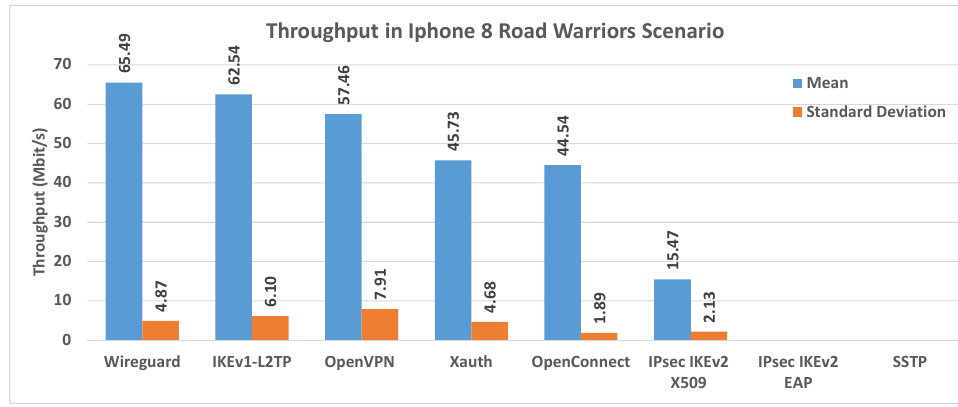
Figure 14. Comparison of Throughputs on iPhone 8 in all scenarios.